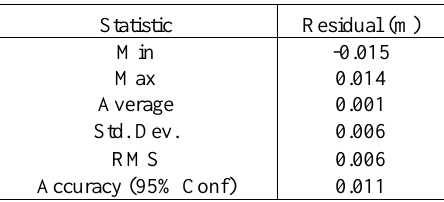
Table 3. Statistical analysis of vertical residuals presented in Figure 13 comparing point cloud measurements with the total station coordinates. (n = 108).